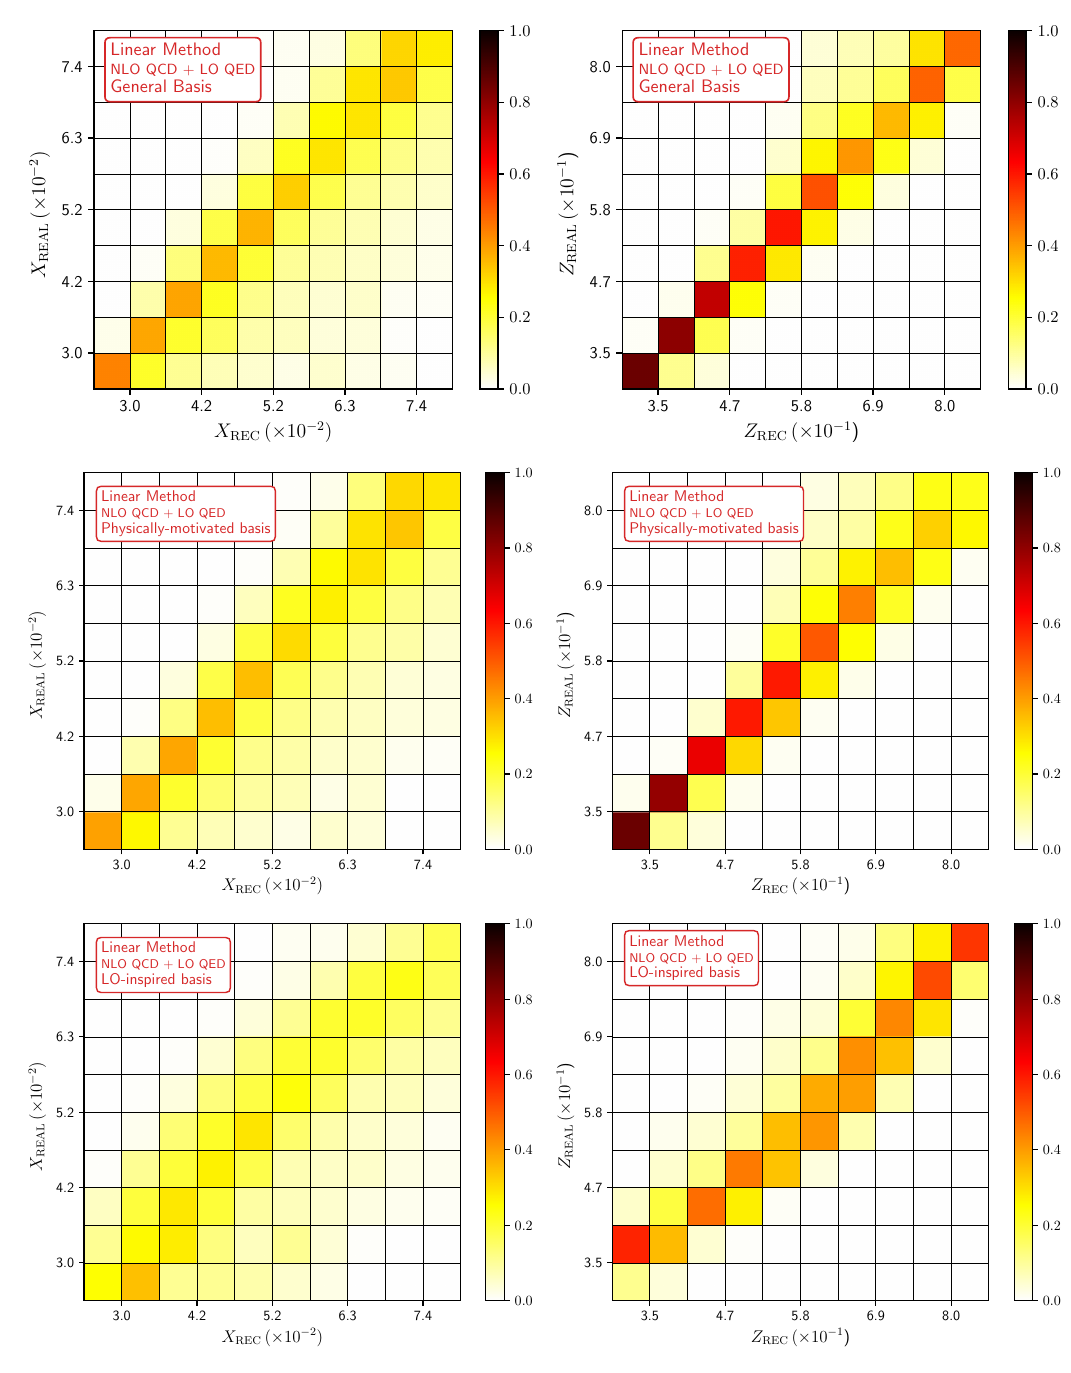
Figure 13: Correlation between the MC momentum fractions (i.e. X and the ones obtained at NLO QCD + LO QED accuracy using the LM approach ( X and Z ). Upper row: using the general basis given in Eq. (38). Middle row: REC physically motivated basis. Lower row: LO-inspired